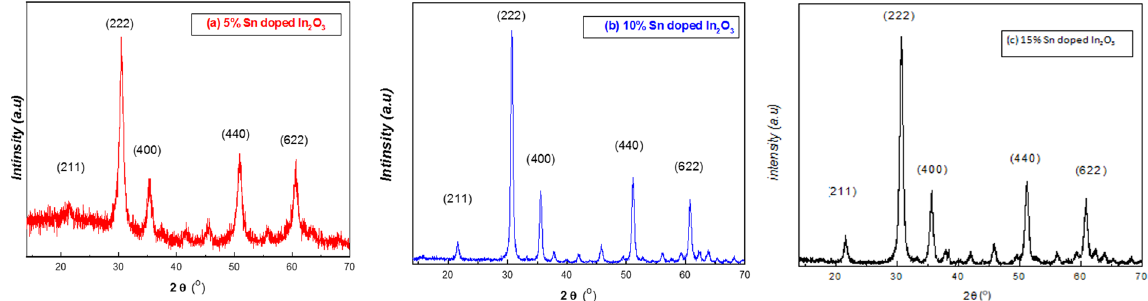
Figure 1. XRD pattern of ( a ) 5% ( b ) 10% and ( c )15% Sn doped indium oxide